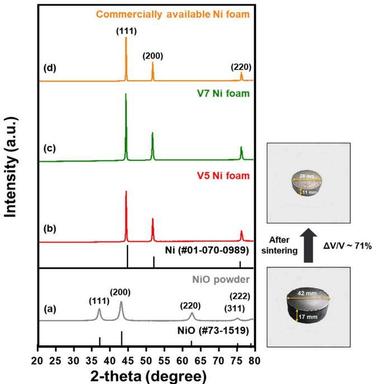
XRD patterns of as-received (a) NiO powder, (b, c) Ni foams fabricated by freeze casting NiO slurry containing 5 vol% and 7 vol% NiO powder and (d) commercially available Ni foam.